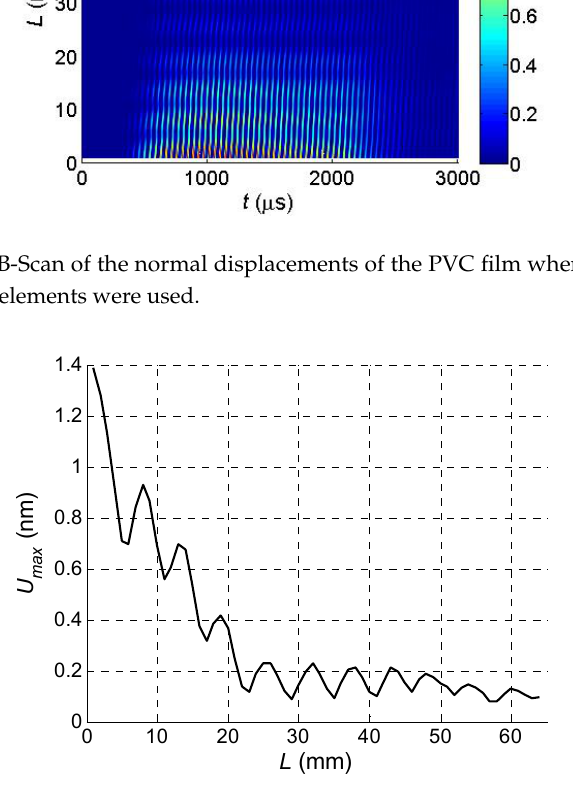
Figure 34. Spatial distribution of the peak values of the normal displacements U max of the PVC film when the optimised time delays between array elements were used.